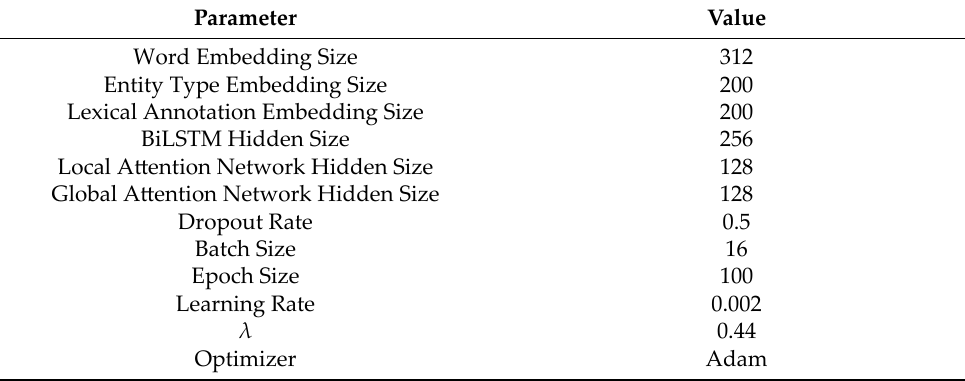
Table 5. Hyper‑parameter settings.